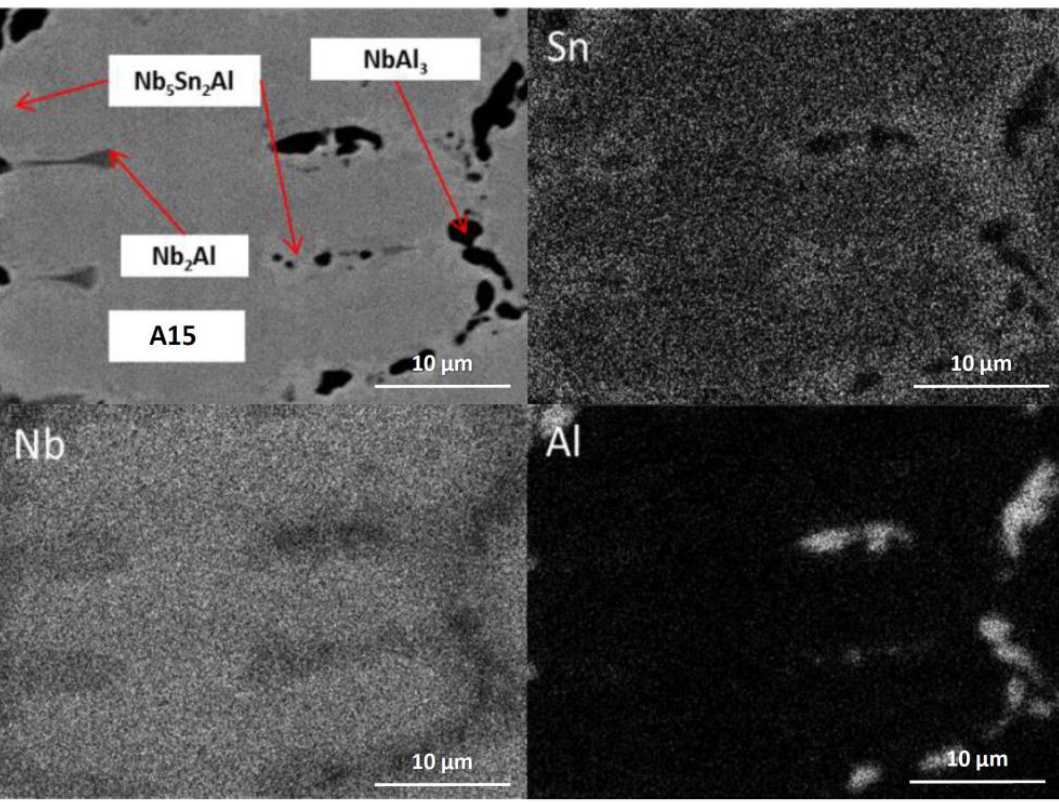
Figure 9. BSE image and X-ray element maps of IP6-HT 900 °C/100 h.